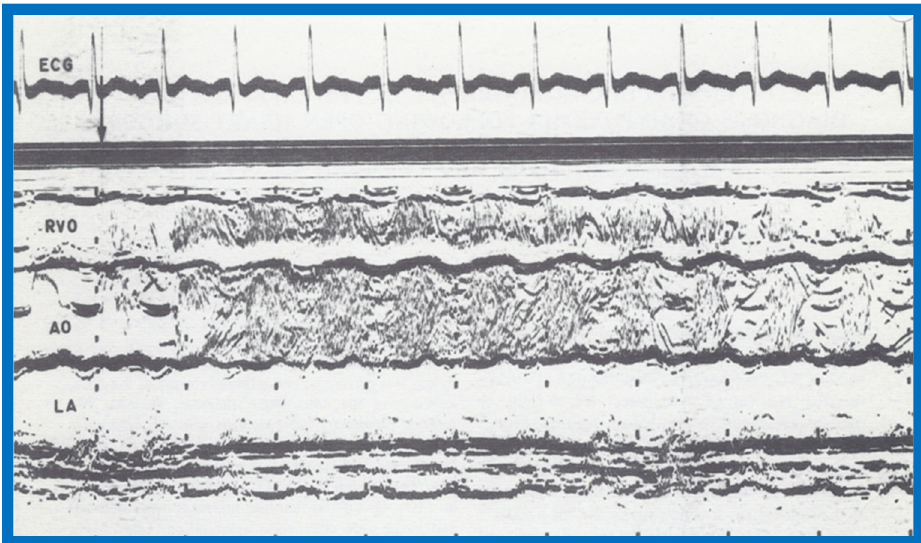
Figure 27. Selected M-mode recording from the parasternal short axis view of the left atrium (LA), aorta (Ao), and right ventricular outflow tract (RVO) while injecting agitated saline into the right atrial line, demonstrating the appearance of contrast echoes almost simultaneously in the Ao and RVO without opacification of the LA, and suggesting that there is no interatrial shunt, and that the shunt is distal to the atria. The time of injection is marked by an arrow at the left top of the figure. ECG, electrocardiogram. Reproduced from Rao P.S., et al. [8].